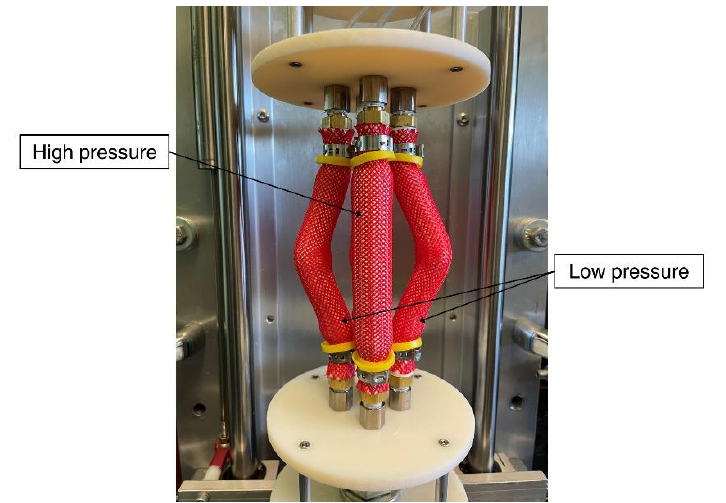
Figure 1. Variable recruitment fluidic artificial muscle (FAM) bundle that consists of multiple motor units (MUs) in parallel connected at each end by rigid plates. A MU is the smallest unit of activation and can consist of one or more FAMs. Inactive/low-pressure MUs buckle outward as active MUs contract.